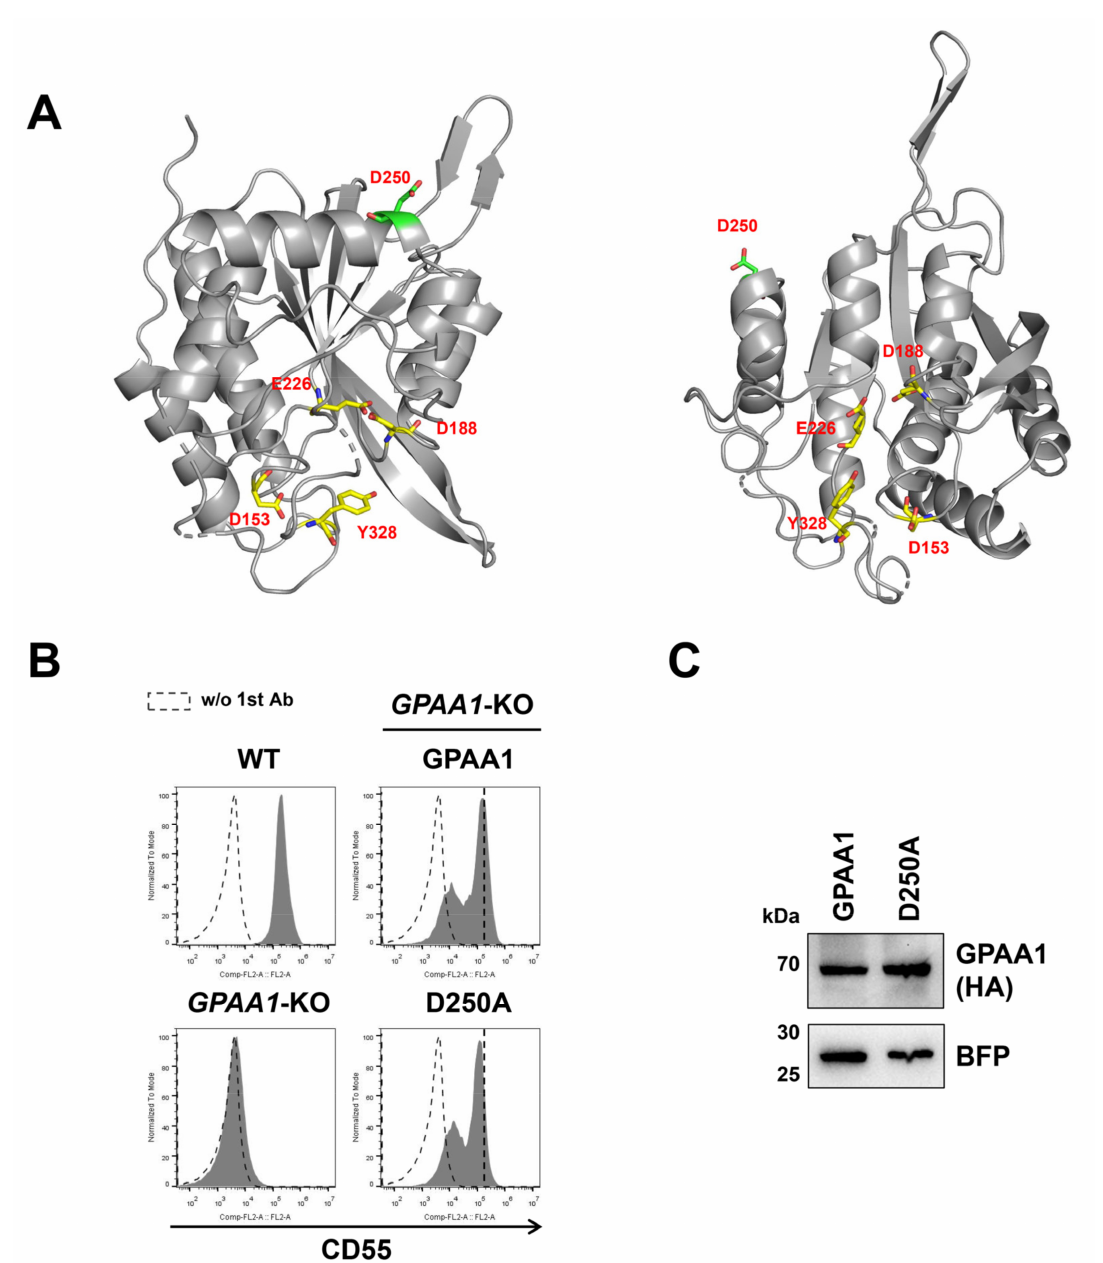
Figure 3. Functionally important residues of GPAA1. ( A ) GPAA1 homology model constructed using the Phyre2 website. The D250 residue is depicted in green, and the residues for putative metal binding sites are depicted in yellow. ( B , C ) GPAA1 - KO cells were transiently transfected with both a plasmid expressing GPAA1-3HA (wild-type or D250A) and a plasmid expressing BFP. The BFP-positive cells were gated, and the surface expression of CD55 was analyzed by flow cytometry ( B ). Protein levels of GPAA1-3HA were detected by western blotting ( C ). BFP was used as a control to check the transfection levels and